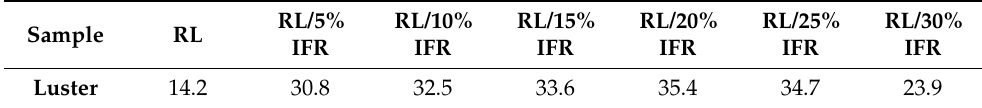
Table 5. Optical performance of RL/IFR films.